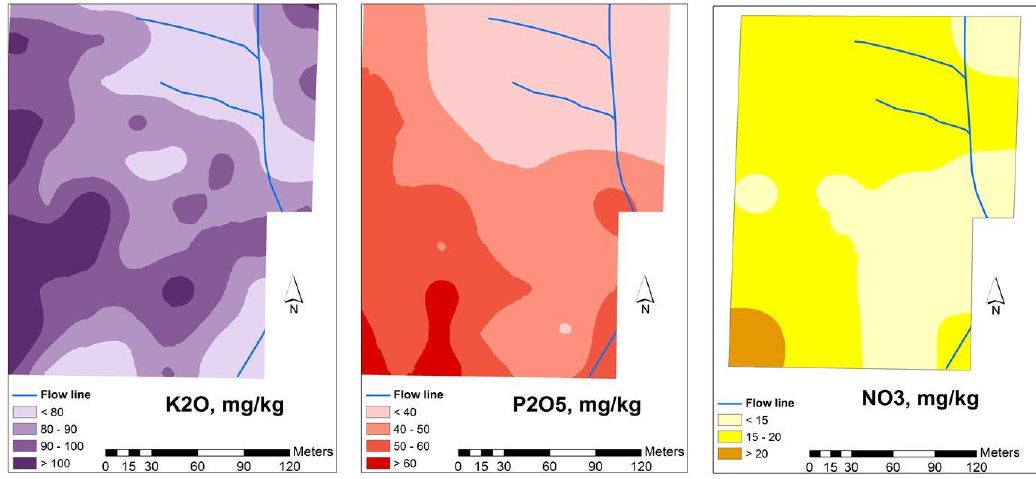
Figure 5. Macronutrients (K